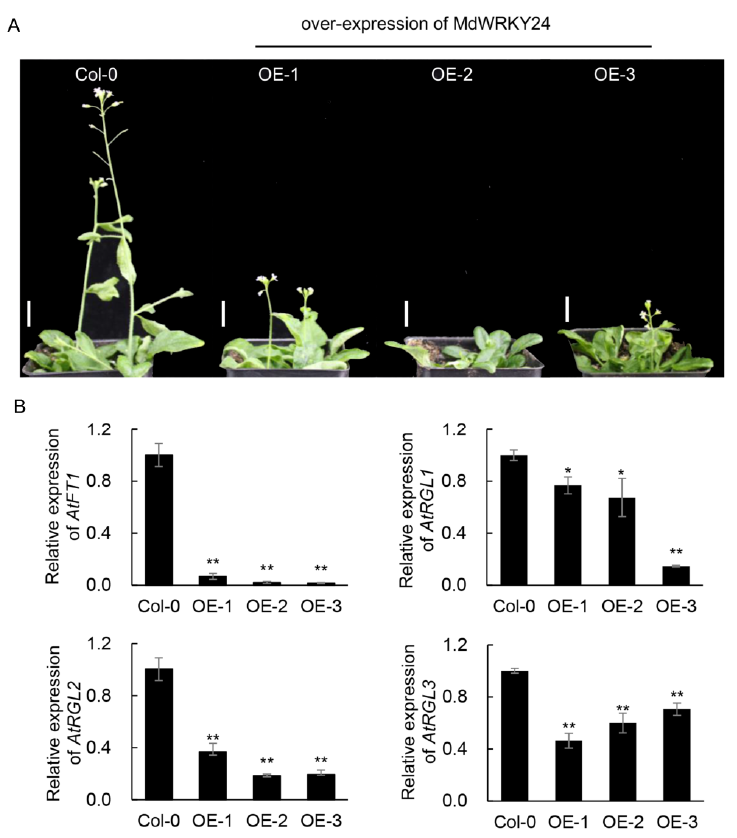
Figure 8. MdWRKY24 overexpression and qRT-PCR detection of gene expression in transgenic Arabidopsis . ( A ): Phenotype; ( B ): gene expression. OE-1, OE-2, and OE-3 are Arabidopsis overexpression lines. Scale white bar = 2cm . * Mean p -value < 0.05; ** mean p -value < 0.01.